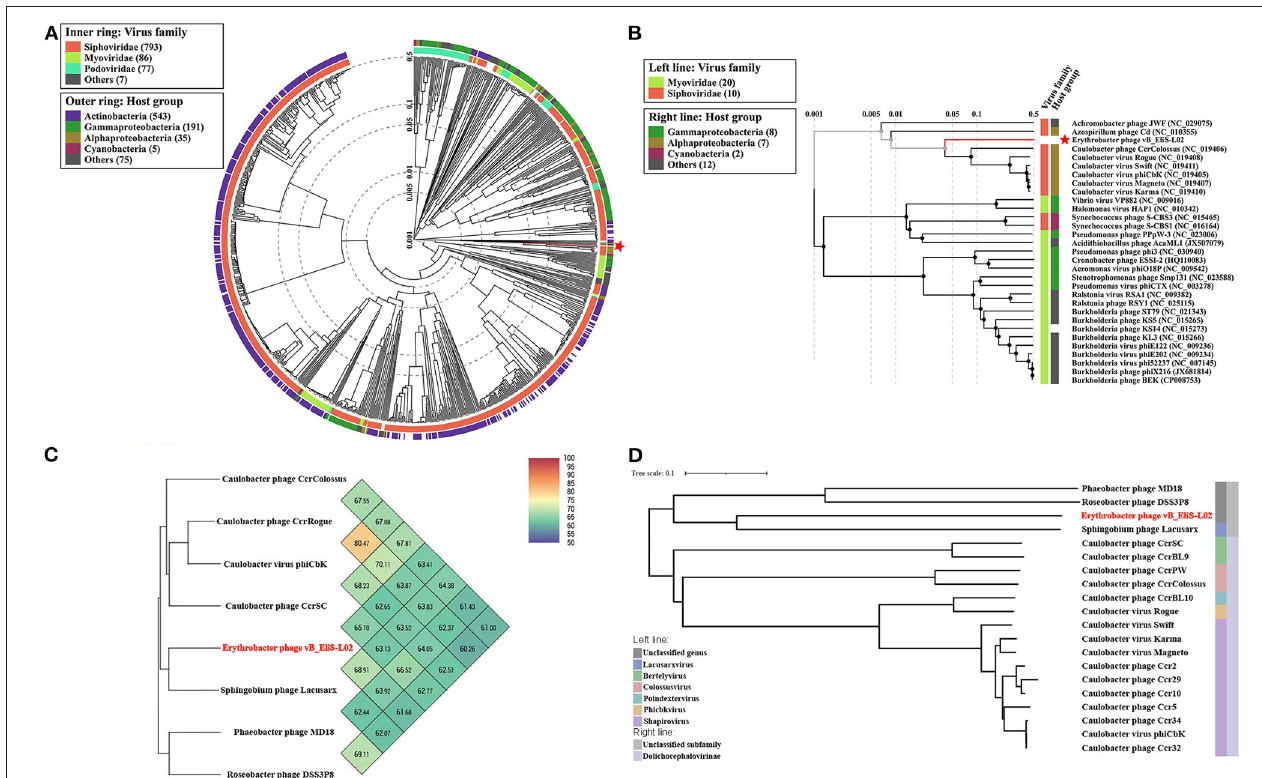
FIGURE 2 | Phylogenetic and comparative analysis of phage vB_EliS-L02. (A) Determination of taxa and host group by a proteomic tree using VipTree including all compared sequences. The colored rings represent for virus family (inner ring) and host group (outer ring). (B) Phylogenetic tree including vB_EliS-L02 and 30 closest virus genomes. The branch length scale was calculated as log values. The left and right color bars indicate the taxonomic virus family and host group, respectively. The red star marks the position of vB_EliS-L02. (C) Heat map showing OrthoANI values of vB_EliS-L02 and the most genetically similar phages. The values were calculated by using OAT software. (D) Whole genome–based phylogenetic tree constructed by VICTOR with phage vB_EliS-L02 and other Cbk-like phages. Each genus is represented by a unique